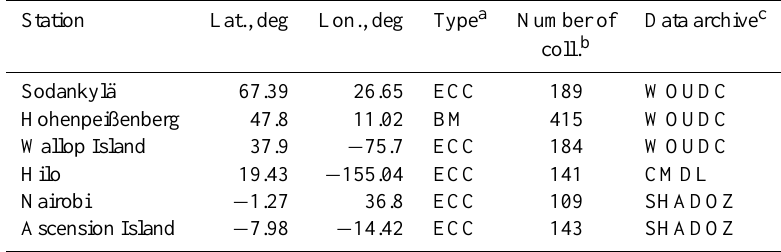
a Ozonesonde types: Electrochemical cell (ECC) and Brewer–Mast (BM). b Number of collocated profiles between OMI and sonde during the period 2004 to 2008. c Data are downloaded from the WOUDC (http://www.woudc.org) data archive, except for Nairobi and Ascension Island, which are from the SHADOZ data archive (http://croc.gsfc.nasa.gov/shadoz), and Hilo, which is from the NOAA Climate Monitoring